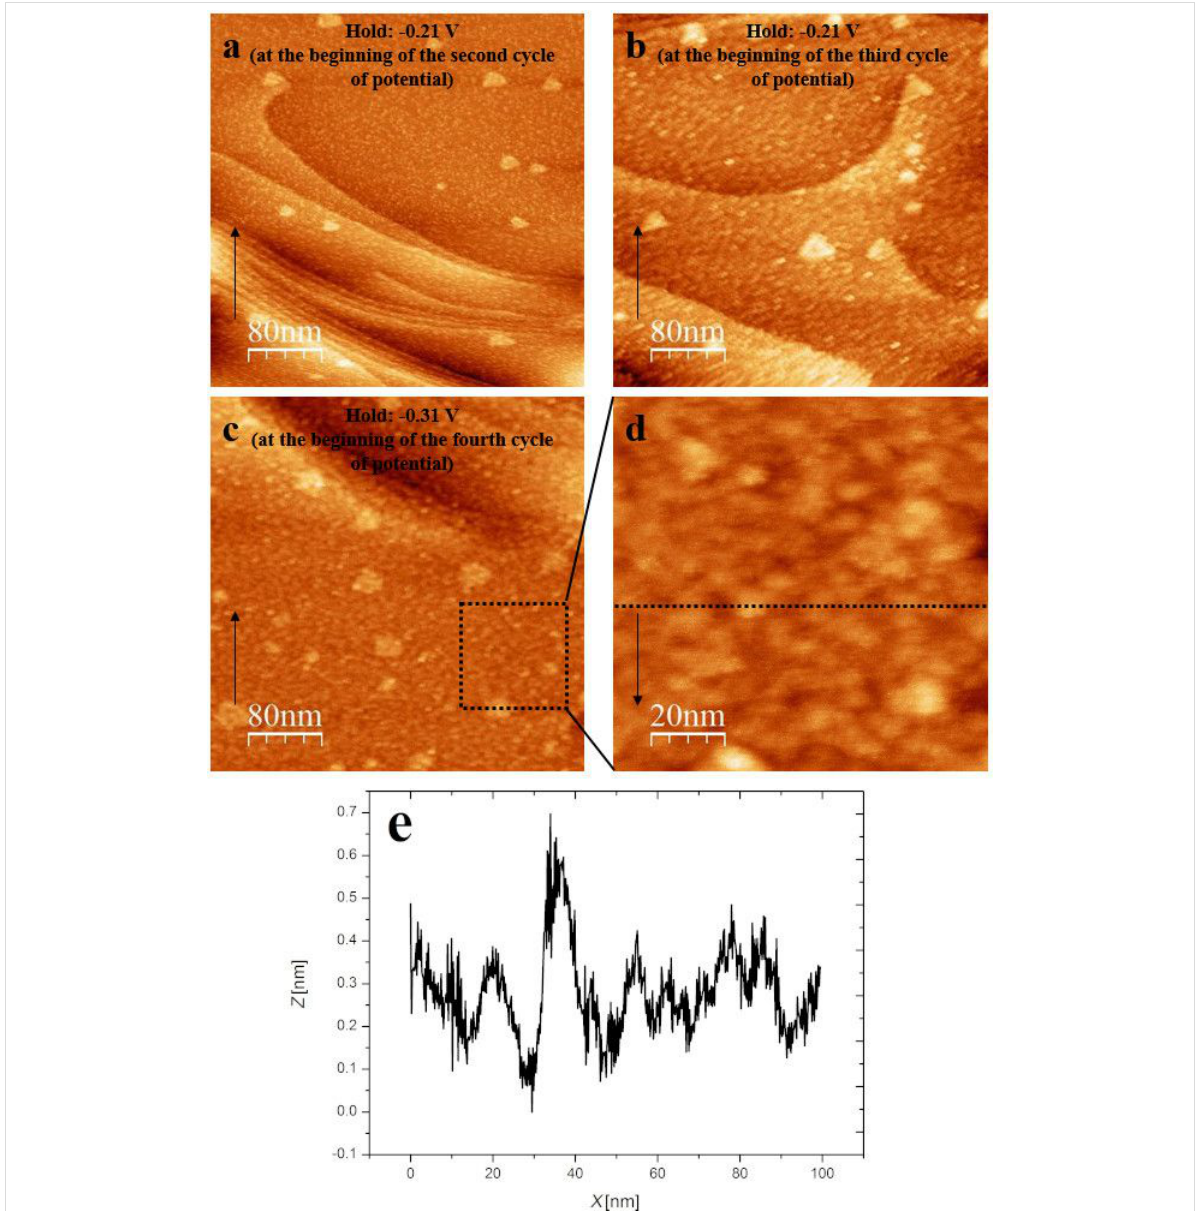
Figure 8: STM images of the Au(111) surface after Sb stripping in 0.25 mM Sb 2 O 3 /0.5 M H 2 SO 4 electrolyte. (a) The potential was held at − 0.21 V after the first potential cycle. (b) The potential was held at − 0.21 V after the second potential cycle. (c) The potential was held at − 0.31 V after the third potential cycle. (d) The zoomed in details of image c (black box) and (e) the cross section of image d (black dotted line). Sample bias = 50 mV, set point = 0.5 nA and scan rate = 3.04 ln/s. Integral gain: 6 and proportional gain: 8. The arrows indicate the scan direction. Line-by-line correction was used for the